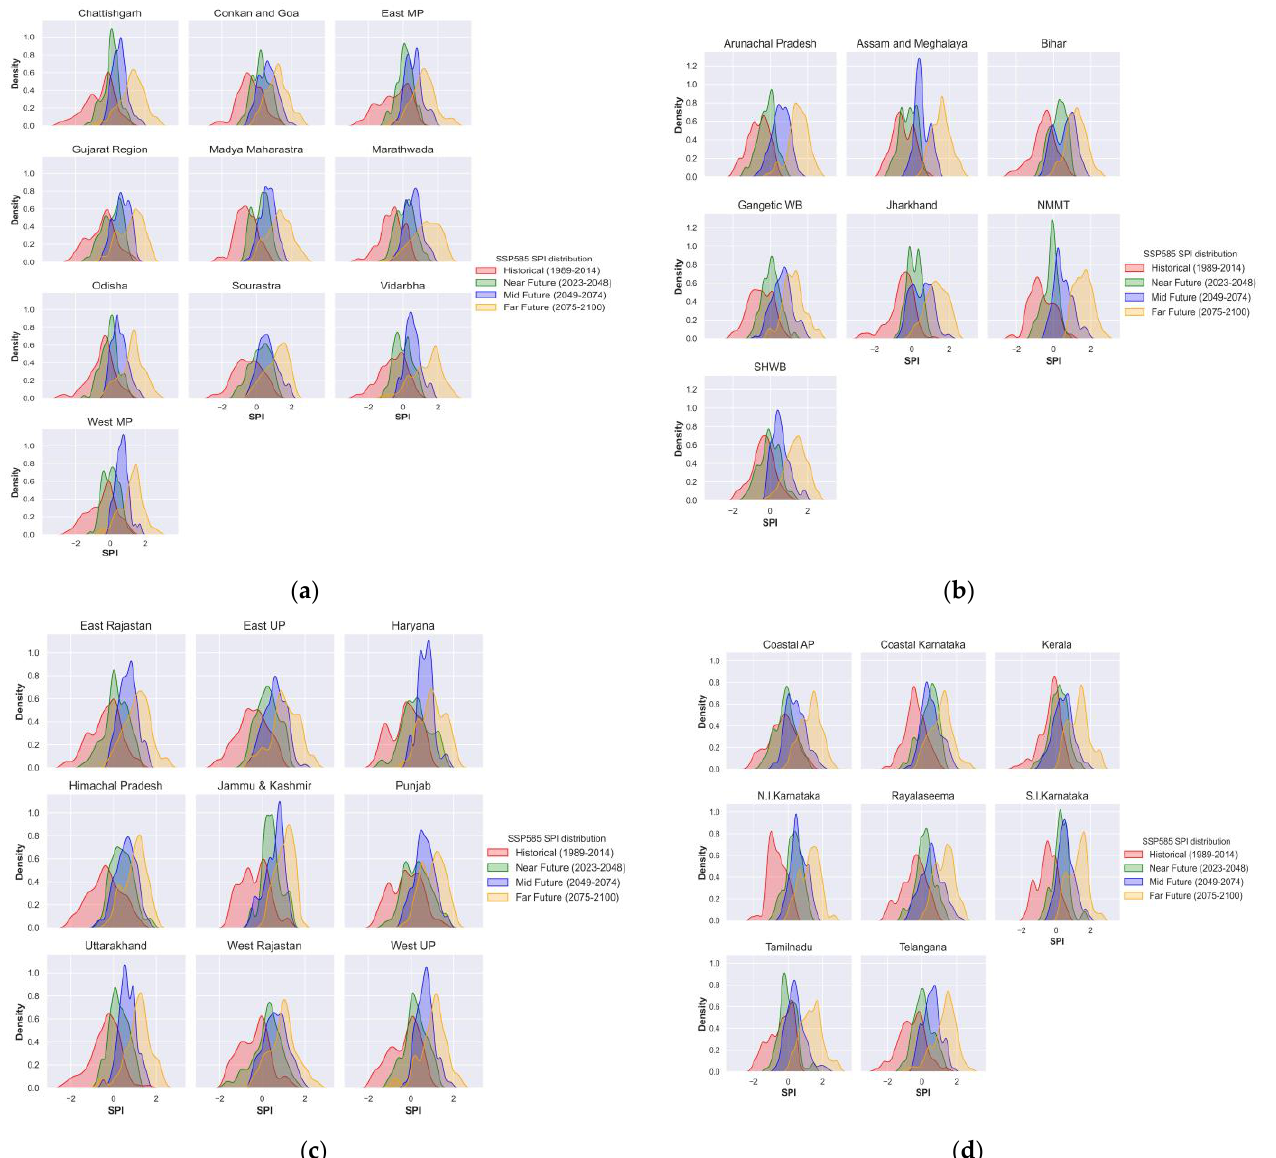
Figure 12. CMIP6 SSP585 scenarios 12-month Standard Precipitation Index (SPI) PDF plot at meteorological subdivision level ( a ) Central India, ( b ) East and Northeast India, ( c ) Northwest India, and ( d ) South Peninsula India for near, mid, and far future.